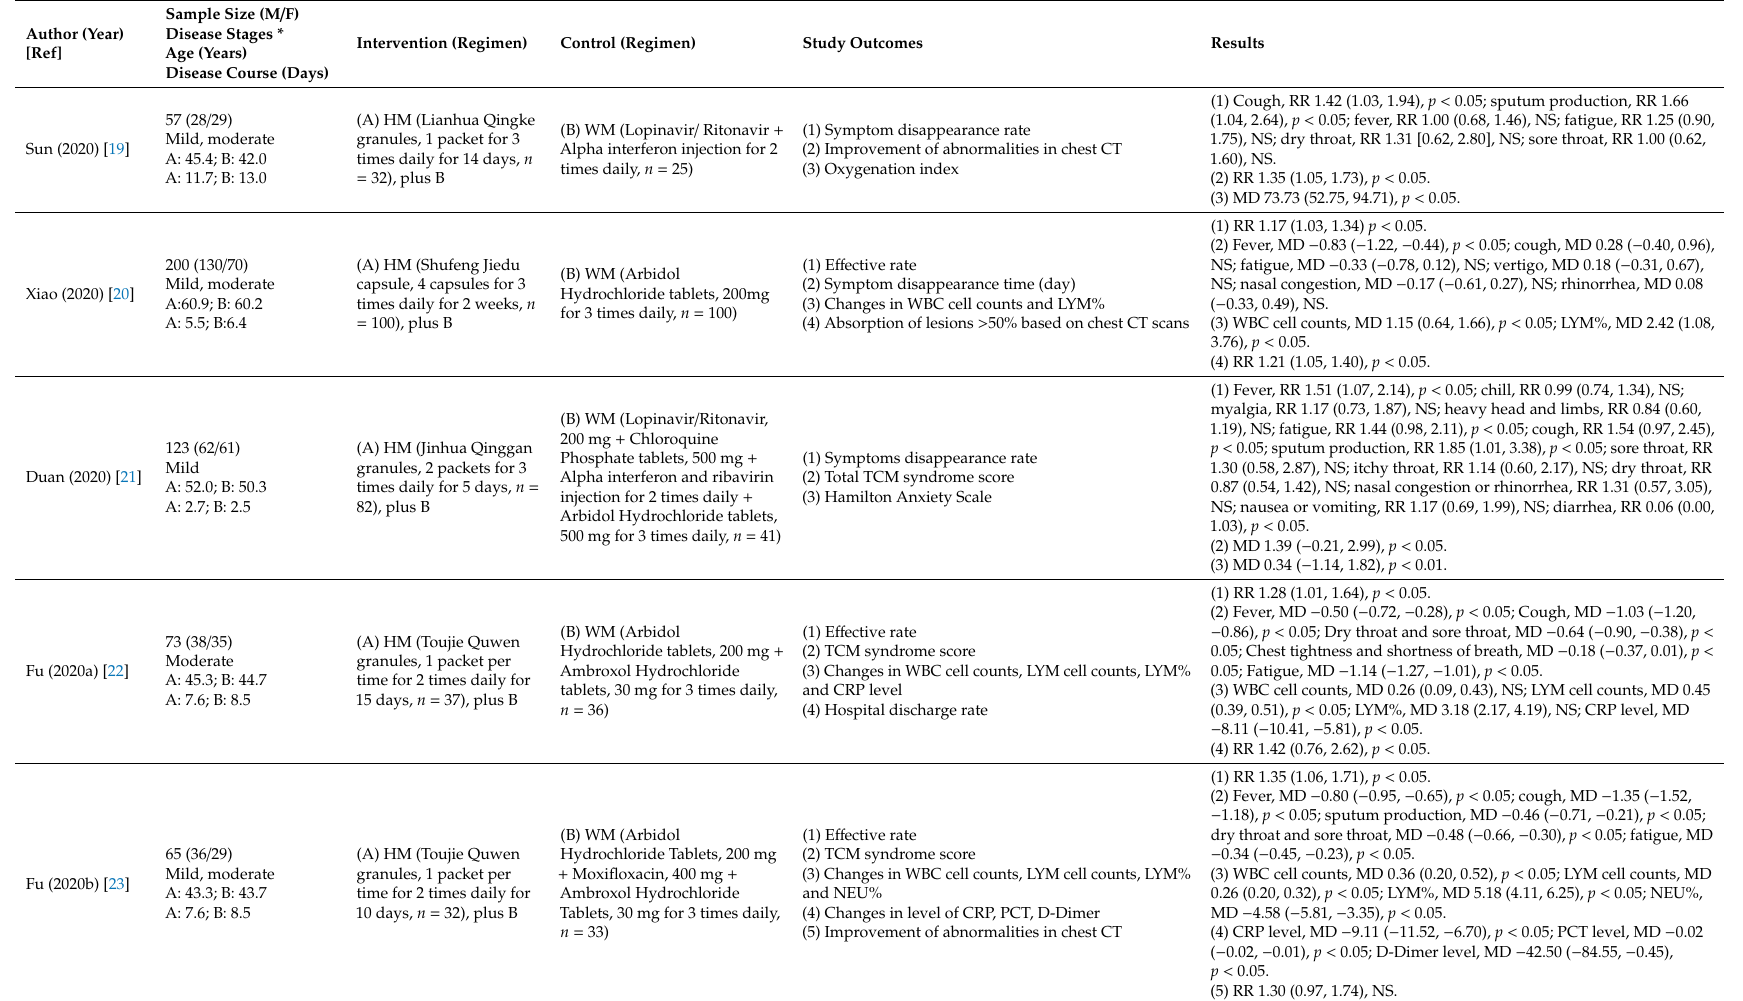
Table 1. Summary of included